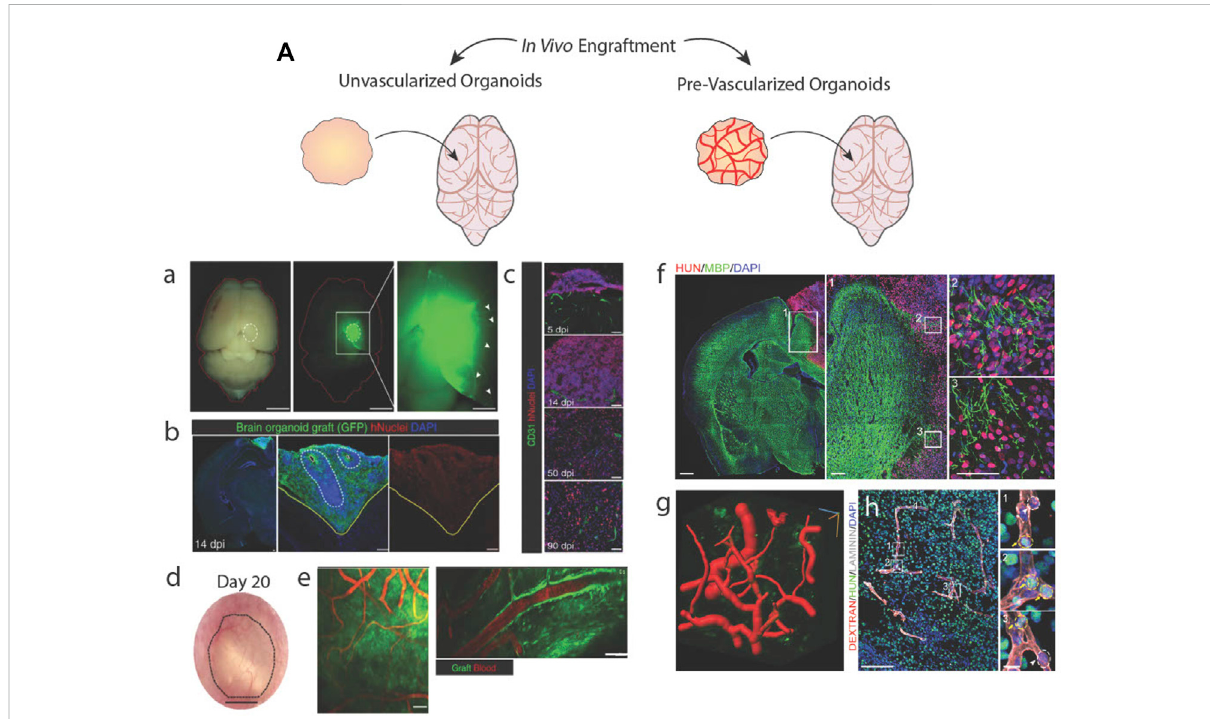
FIGURE 5 Brain organoid vascularization by engraftment into animal hosts. (A) Schematic of unvascularized or pre-vascularized organoids being engrafted in living mice brains. a.b. An unvascularized GFP + brain organoid located in a mouse brain stains positive for a human-speci fi c nuclear marker.c.d.Engrafted brainorganoidexhibitsinvasivehostvessels.e.Vesselslocatedinthegraftperfuseblood.Adaptedfrom(Mansouretal.,2018). A vascularized brain organoid located in a mouse brain stains positive for a human-speci fi c marker and interacts with host tissues. g. Computational rendering of vessels within the organoid graft. h. Vessels within the graft perfuse a labelled dextran injected into the host mouse. Adapted from (Shi et al.,